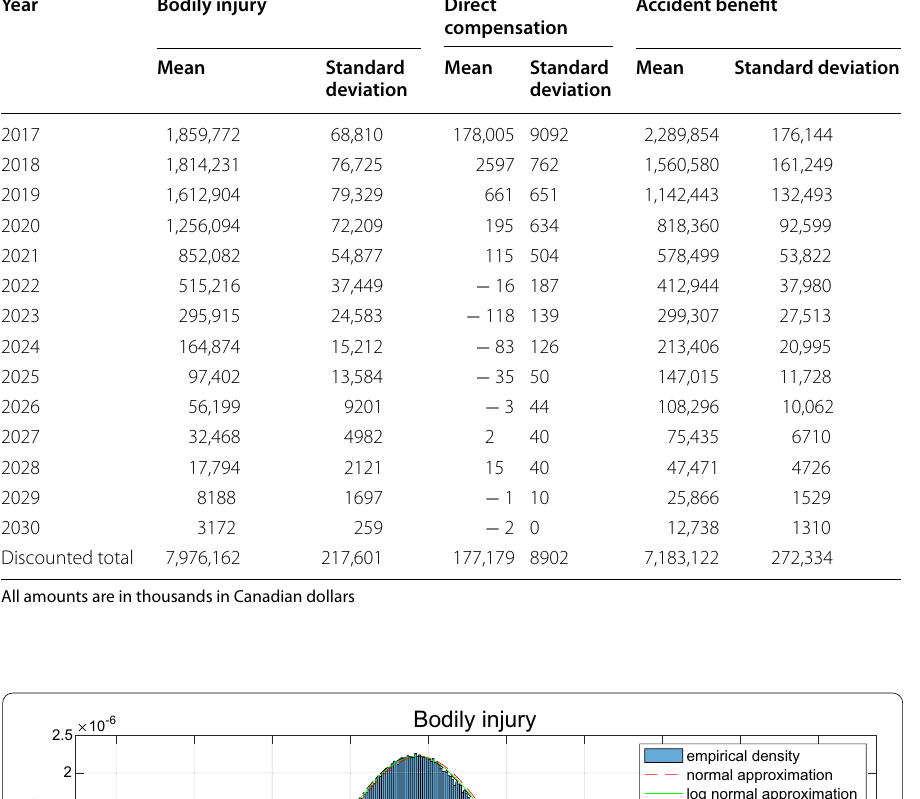
Table 10 Mean and standard deviation for unpaid losses in future years